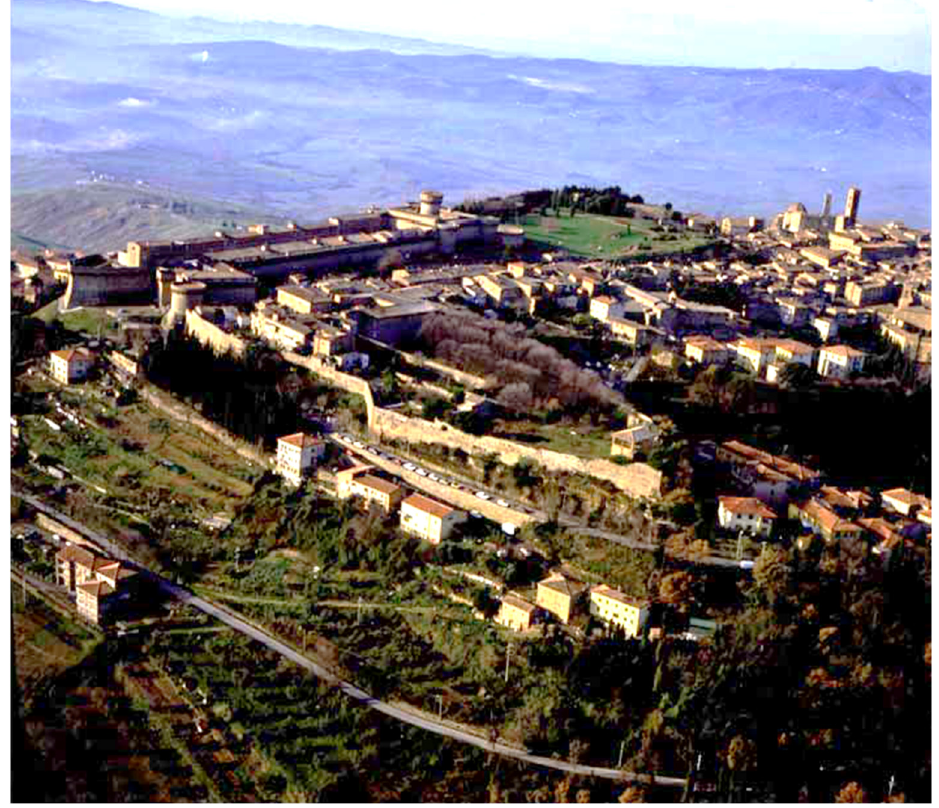
Figure 1. Aerial view of the Volterra urban walls and the fortress [35].